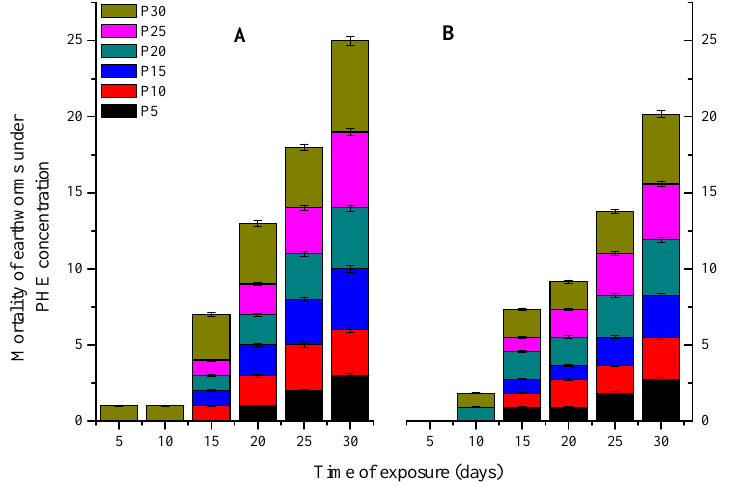
Figure 2. Mortality of E fetida ( A ) and A. caliginosa ( B ) under phenanthrene stress at different concentration (5, 10, 15, 20, 25 and 10 mg kg − 1 ).